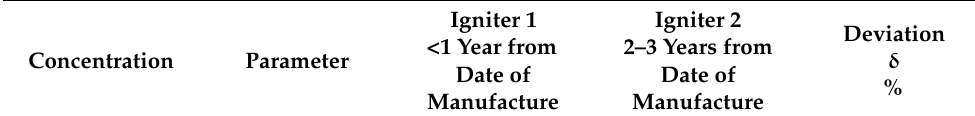
Table 1. Maximum values of explosion parameters for individual concentrations attained during the Igniter 1 and Igniter 2